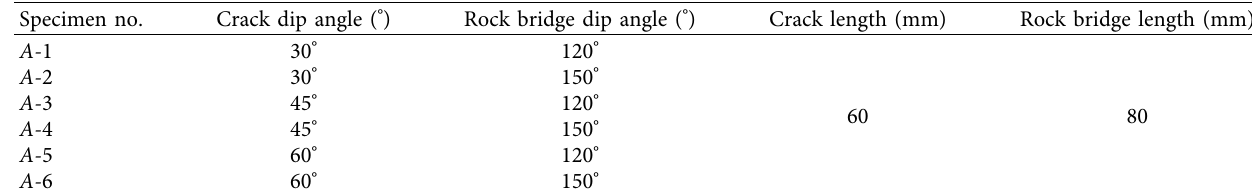
Figure 3: The arrangement of AE sensors. Table 2: Specimen crack